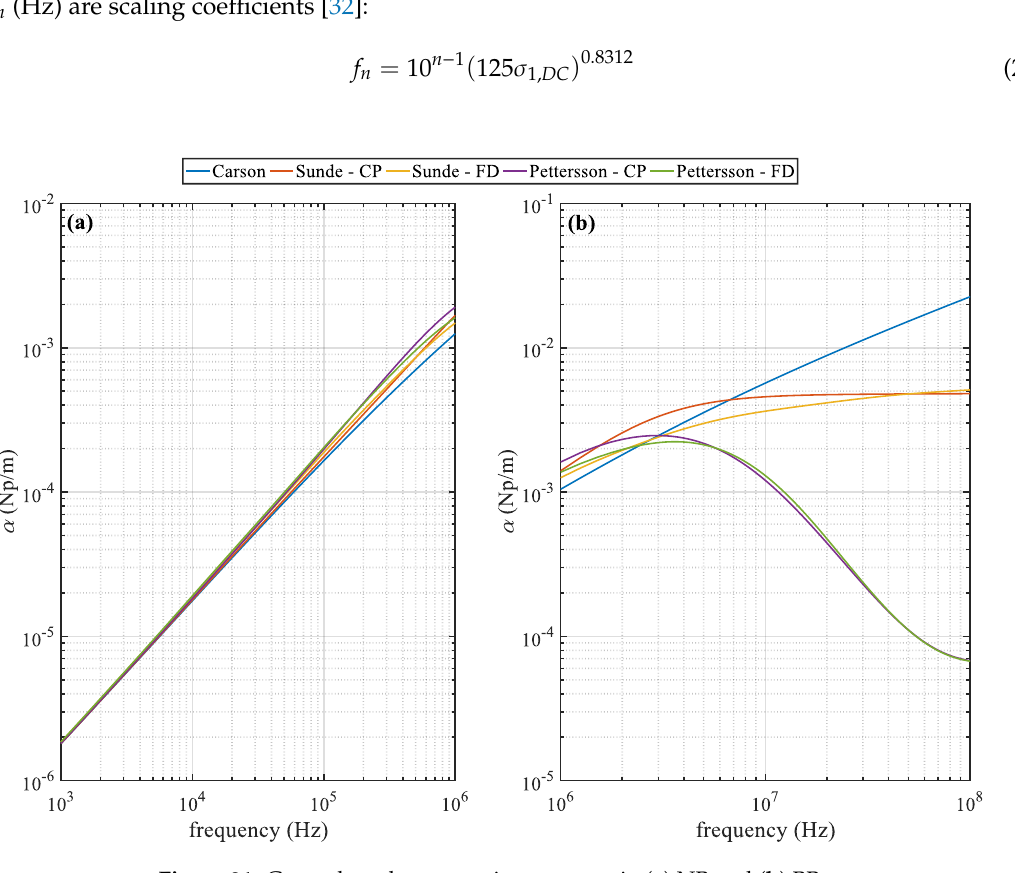
Figure 21. Ground mode attenuation constant in ( a ) NB and ( b ) BB.